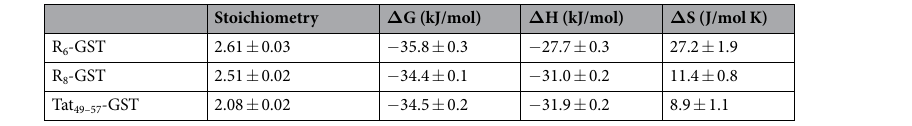
Table 1. Thermodynamic parameters of AR aptamer interaction with R 6 -GST, R 8 -GST and Tat 49–57 -GST determined according to the one set of sites model with assumption that the ligand is in the measurement